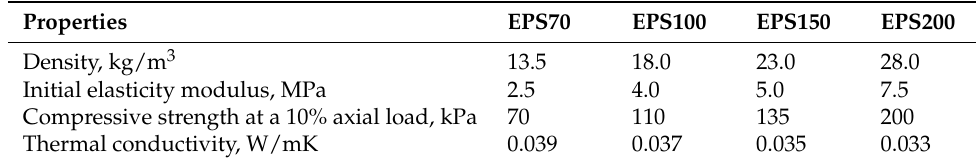
Table 1. EPS material